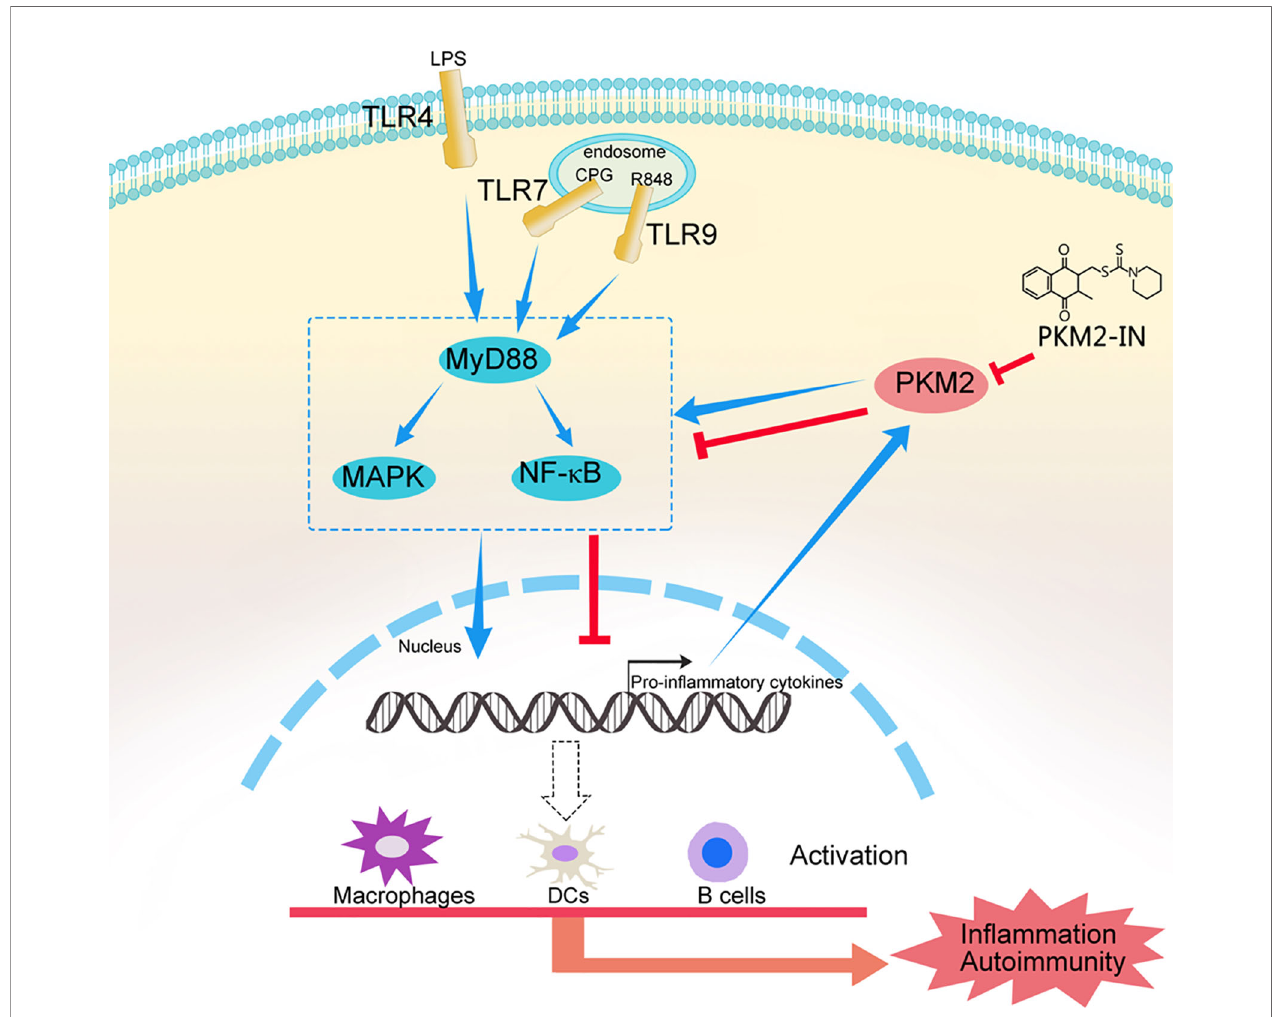
FIGURE 10 | A model of the mechanism whereby PKM2 participates in the pathogenesis of TLRs-mediated in fl ammation and autoimmunity. This schematic shows that hyper-activation of TLRs lead to PKM2 over-expression and PKM2 augments TLR4/TLR7/TLR9-induced activations of macrophages, DCs and B cells by promoting Pyk2 activation, thereby contributing to the pathogenesis of TLRs-mediated in fl ammation and autoimmunity. Pharmaceutical inhibition of PKM2 by PKM2-IN can inhibit TLR4/TLR7/TLR9-induced activations of macrophages, DCs and B cells, and alleviate the pathogenesis of TLRs-mediated in fl ammation and